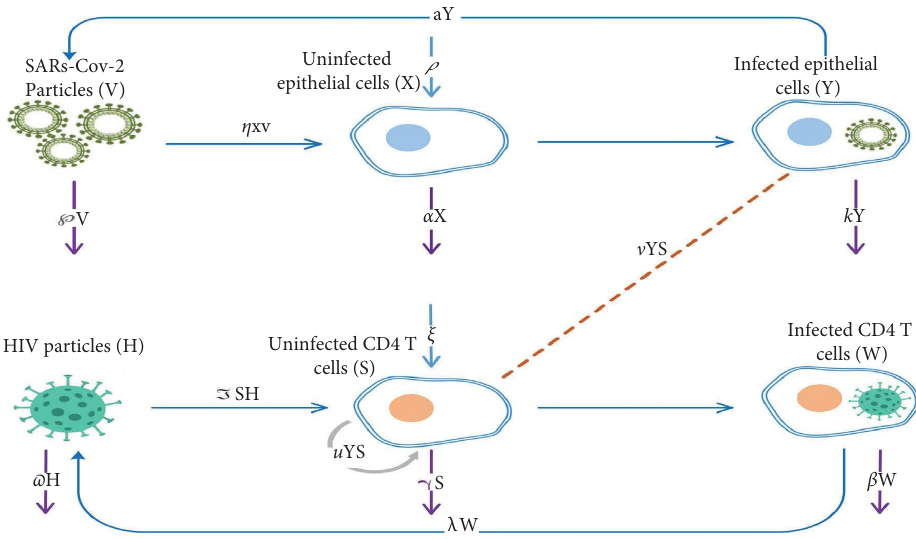
Figure 1: Scheme describing the coinfection between SARS-CoV-2 and